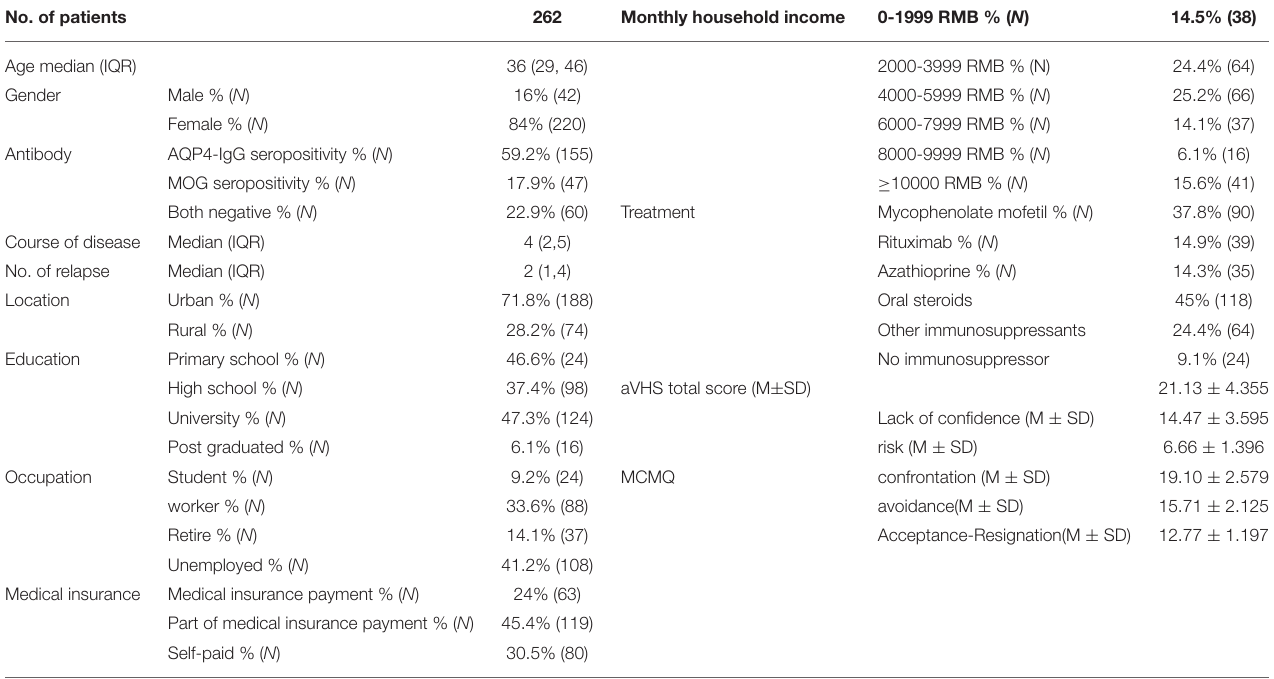
TABLE 1 | Characteristics of study participants with NMOSD.